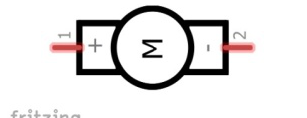
Fig. 11. Schematic diagram and pinout of a DC motor